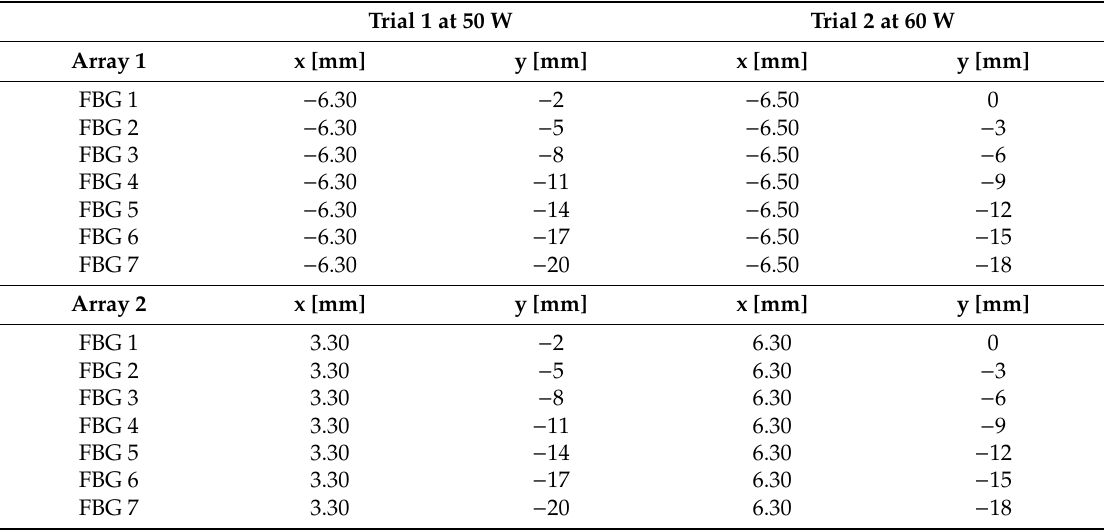
Table 2. Coordinates of the FBGs embedded in Arrays 1 and 2 for the configurations referred to the 50 and 60 W experiments. The tip of the RF antenna is considered to be the origin of the axes. Trial 1 at 50 W Trial 2 at 60